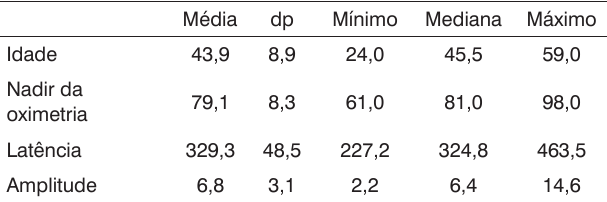
Tabela 4. Grupo SAOS: média, desvio padrão, valores mínimo, amplitude do P 300 (N=54).